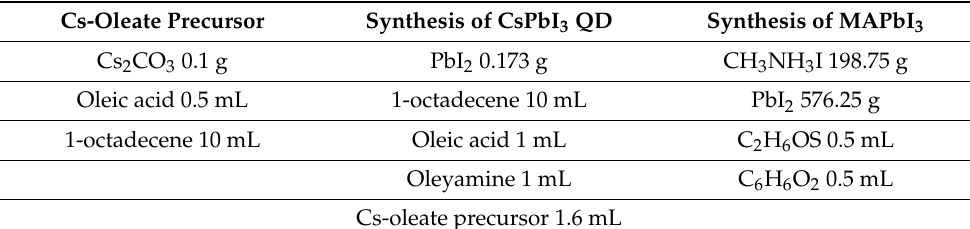
Table 1. Preparation parameters of Cs-Oleate Precursor, CsPbI 3 QDs and CH 3 NH 3 PbI 3